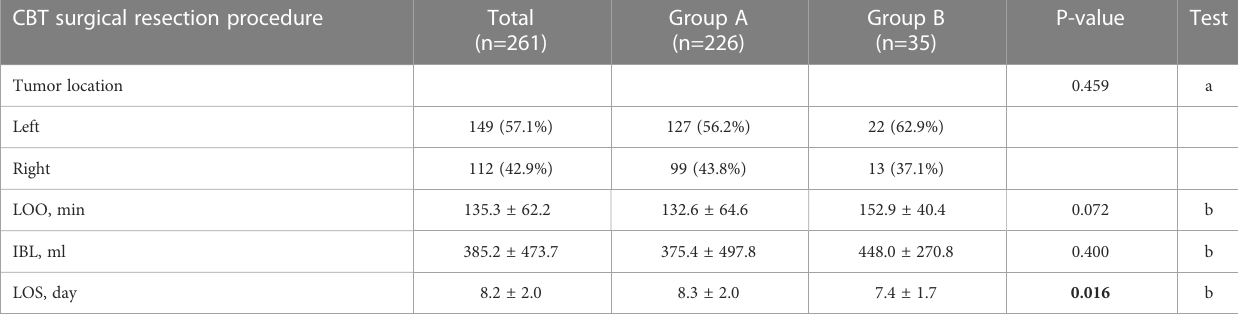
TABLE 4 Technical data of CBT surgical resection procedure for patients without (group A) or with preoperative embolization (group B). CBT surgical resection procedure